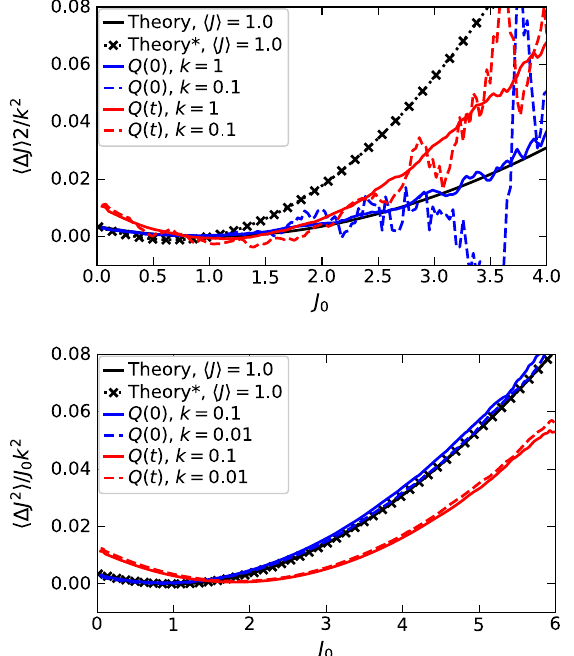
FIG. 3. Change of action after a single kick of amplitude k as a function of the particles ’ initial action. Macroparticle simulations were run with constant tunes, Q ð 0 Þ , and dynamically evolving tunes, Q ð t Þ . They are compared to a theory assuming constant tunes, and a modified theory*, given by Eq. (10) and Eq. (12), respectively.